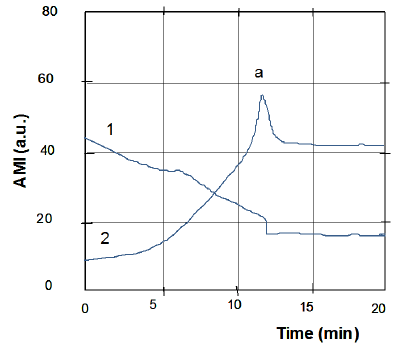
Figure 1 . Change in the amplitude (1) and phase (2) of acoustomechanical impedance (AMI) during drying of a drop of tested fluids on the sensor surface.